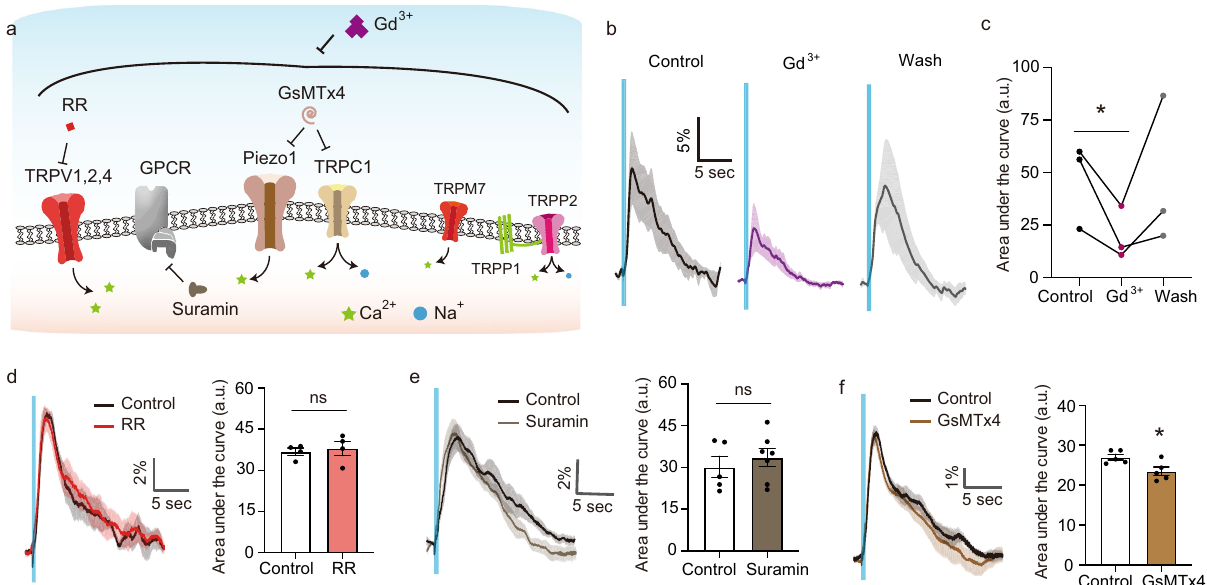
Fig. 4 Pharmacological inhibition of mechanosensitive receptors. a Schematic of neuronal mechanosensitive receptors and strategies to block them. Gadolinium (Gd 3 + , 20 μ M) was used to block the mechanosensitive channels nonspeci fi cally. Pores of TRPV1, 2 and 4 channels were blocked by ruthenium red (RR, 1 μ M). Activation of GPCRs was inhibited by suramin (60 μ M). Gating of Piezo1 and TRPC1 channels was inhibited by GsMTx4 (10 μ M). b Calcium responses before, during and after treatment with Gd 3 + . c Average calcium response under each condition ( n = 3 independent experiments, Paired T -test, two-tailed, p = 0.0884). d Calcium responses before and after treatment with RR ( n = 3 independent experiments, unpaired t - test, p = 0.6930). e Calcium responses before and after treatment with suramin ( n = 5 independent experiments for control, and seven independent experiments for suramin, unpaired t -test, two-tailed, p = 0.5159). f Calcium responses before and after treatment with GsMTx4 ( n = 5 independent experiments each, unpaired t -test, two-tailed, p = 0.0245). Mean trace is solid and SEM is shaded. Bar graph values represent mean ±